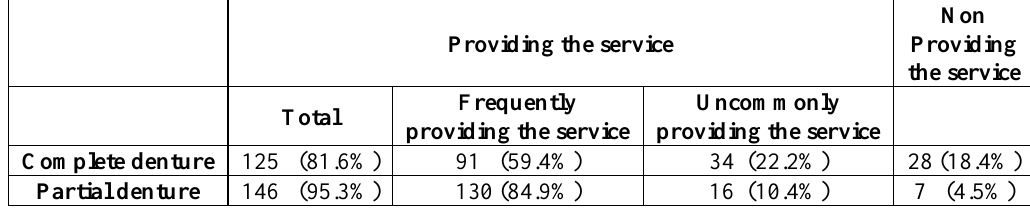
Table 3: Conventional complete and partial denture construction among participants